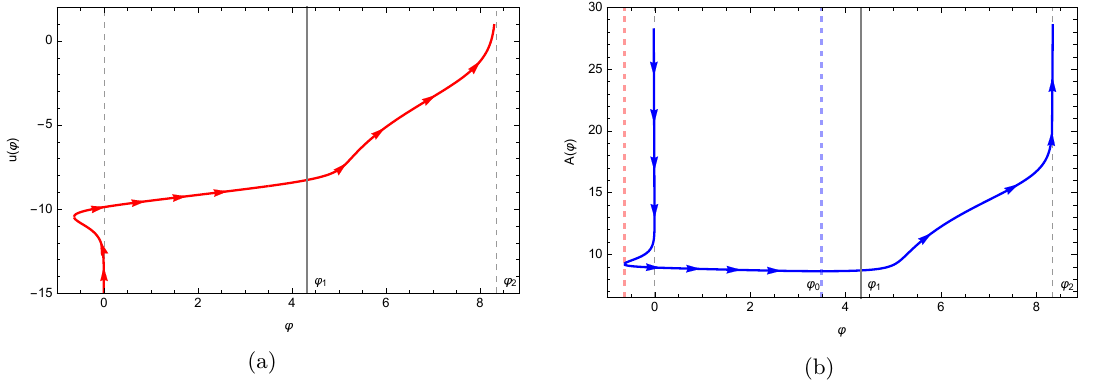
Figure 28 . (a): a zoomed picture of the space of the W LR the flow in the diagram (b). (b): the flows of type W LR There is a ϕ -bounce at ϕ < 0 , the red dashed line. Notice that the red region at S is the space of solutions with an extra ϕ -bounce near UV